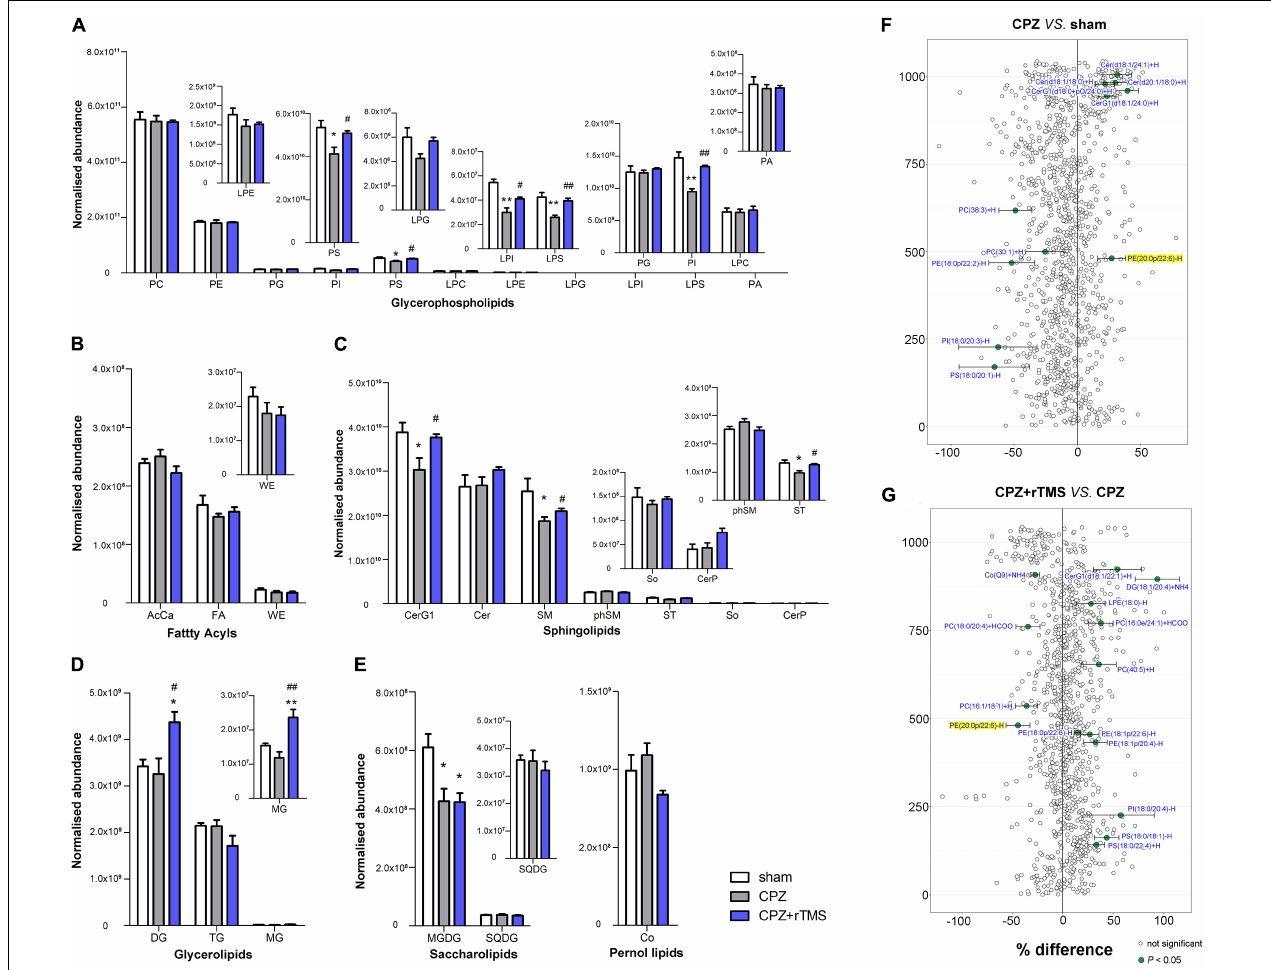
FIGURE 2 | Alteration of lipidomic profiles and the characterization of lipids in the hippocampus of mice in each group. Six main lipid classes were analyzed: (A) glycerophospholipids, (B) fatty acyls, (C) sphingolipids, (D) glycerolipids, (E) saccharolipids, and pernol lipids. Lipids showing low levels results have been enlarged in insets. (F,G) Forest plots of individual lipids in the hippocampus of mice in the CPZ group expressed as a percent difference compared to shams, CPZ + rTMS group expressed as a percent difference compared to the CPZ group. Molecules indicated in green represent significant differences in individual lipids ( P < 0.05). Lipids highlighted in yellow indicate lipids that were modulated in a contrary direction compared to that in the CPZ group. PC, phosphatidylcholine; PE, phosphatidylethanolamine; PG, phosphatidylglycerol; PI, phosphatidylinositol; PS, phosphatidylserine; LPC, lysophosphatidylcholine; LPE, lysophosphatidylethanolamine; LPG, lysophosphatidylglycerol; LPI, lysophosphatidylinositol; LPS, lysophosphatidylserine; PA, phosphatidic acid; AcCa, acylcarnitine; FA, fatty acid; WE, wax esters; Cer, ceramides; CerG, glucosylceramides; SM, sphingomyelin; phSM, sphingomyelin (phytosphingosine); ST,